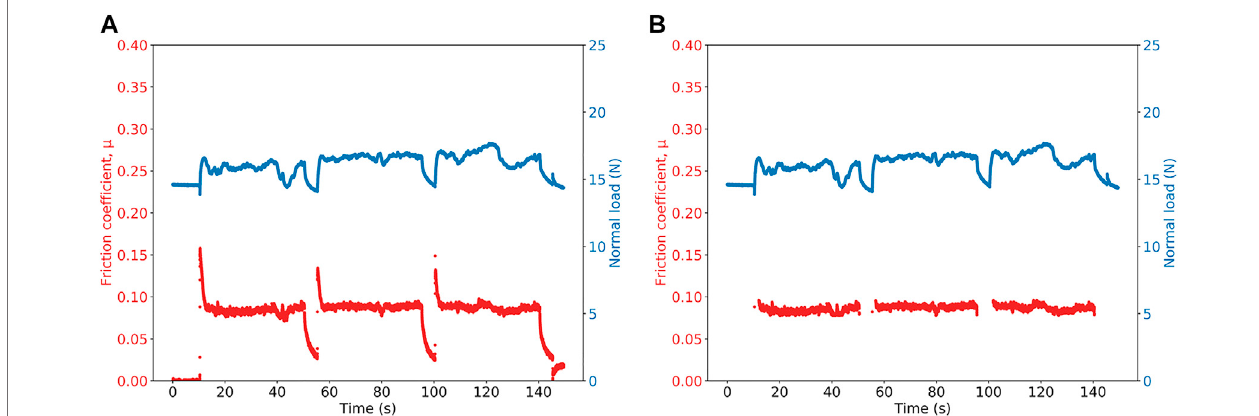
FIGURE2| Typicalrawdatafrom afriction measurement (A) showingfriction coef fi cient, μ ,and normalloadasafunctionoftime.Attheend ofeach ofthreeslides when the probe is static, the values decrease. The data after processing is shown in (B) . The mean coef fi cient of kinetic friction, μ k , is found using these data. This measurement was made on a L (XG) coating at 10% RH and 20 ° C.